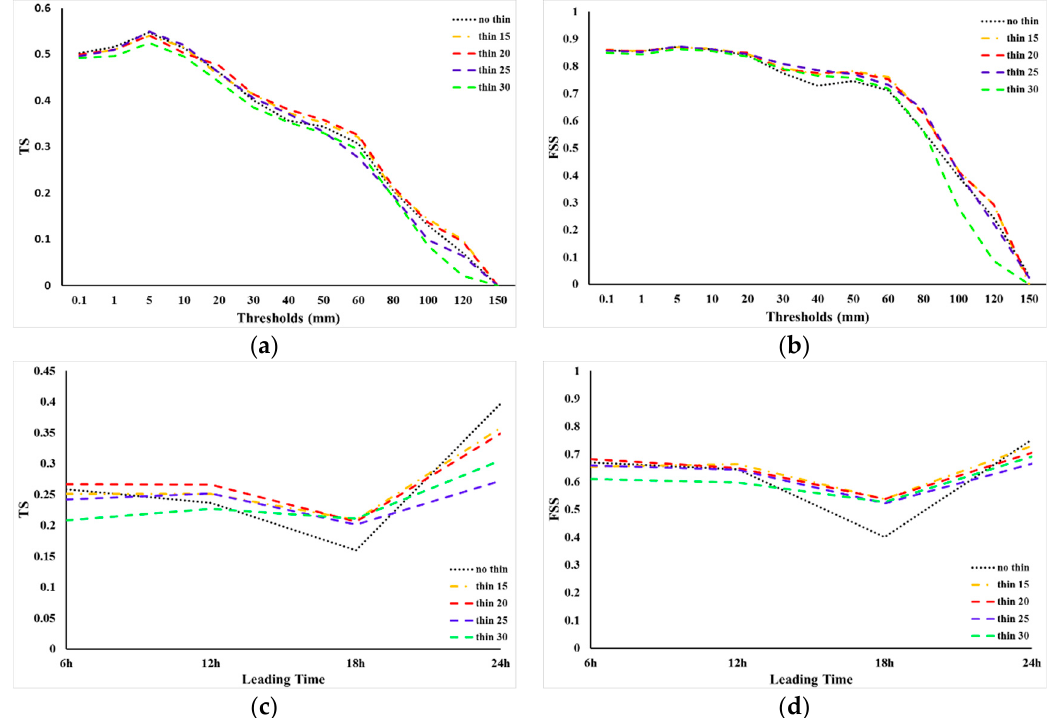
Figure 8. This is similar to Figure 7 but for sensitivity of rainfall forecast skill score to thinning distance.